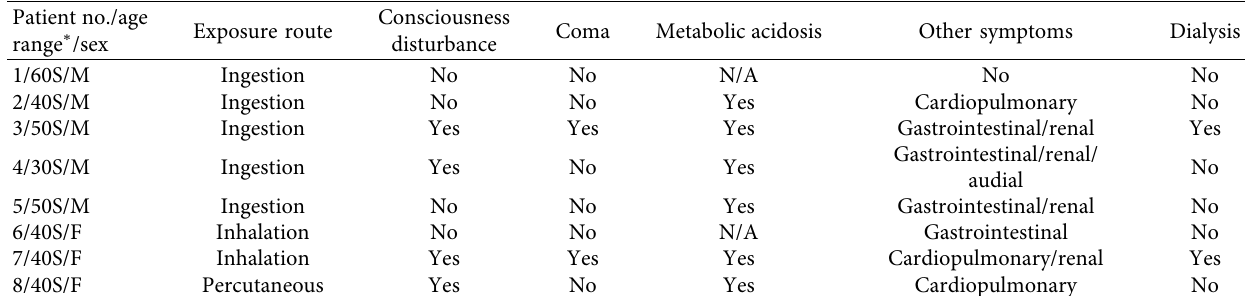
Table 2: Clinical feature and treatment in acute phase.